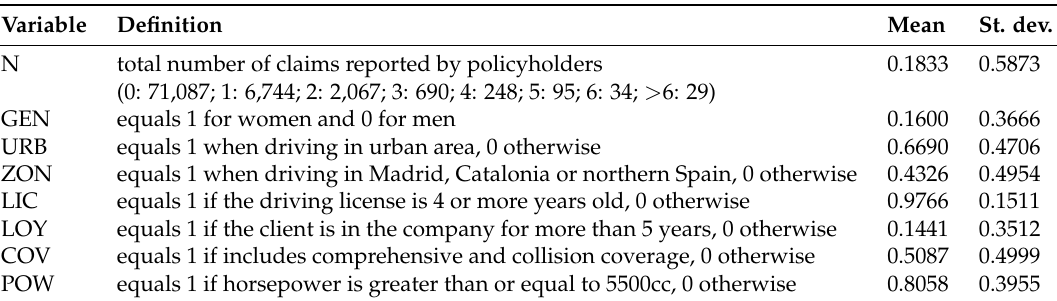
Table 1. Dependent and explanatory variables used in the